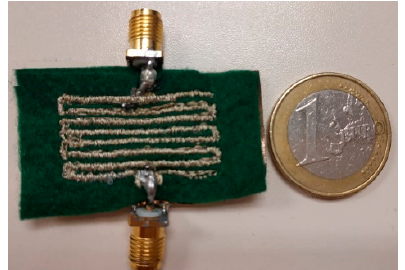
Figure 3. Photograph of the embroidered design.